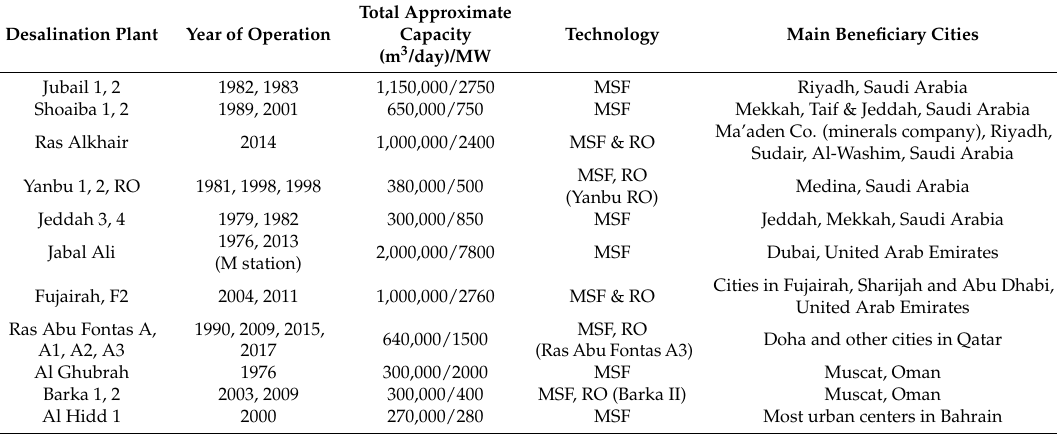
Table 3. Largest desalination plants in the GCC and beneficiary